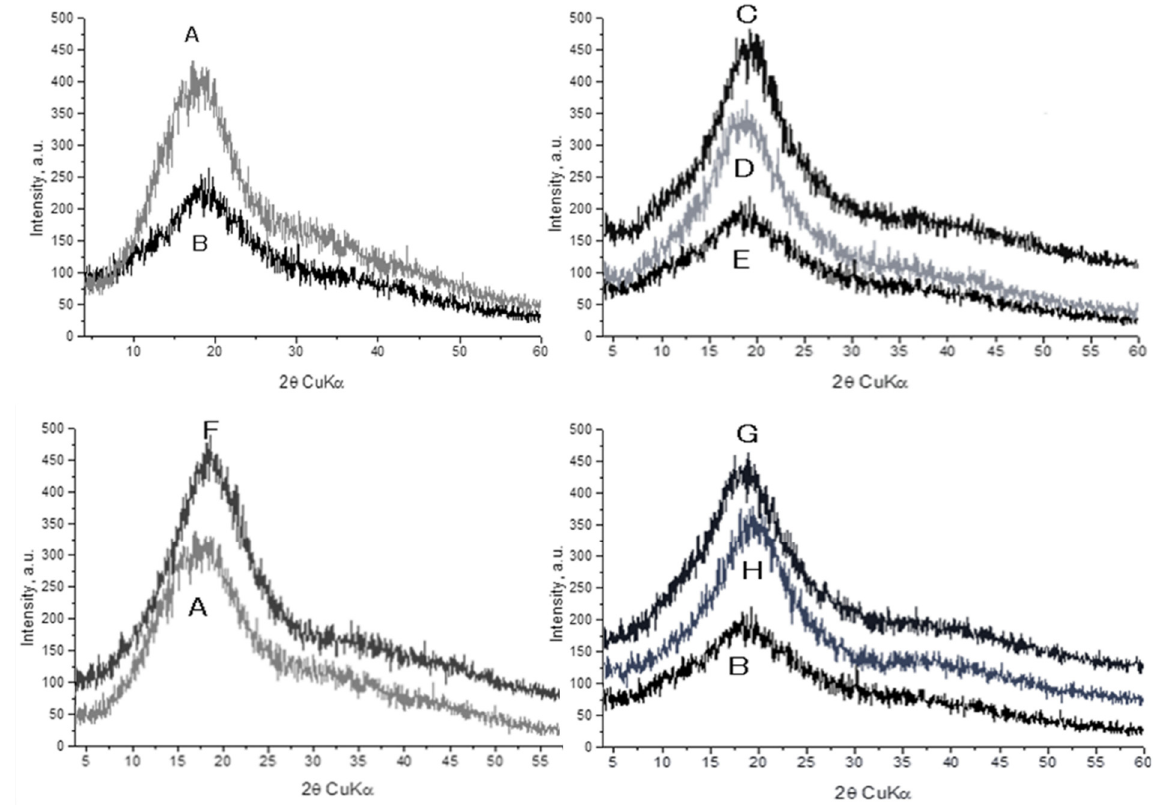
Figure 2. XRD spectra of the raw materials and the formulated samples: maltodextrin ( A ), Arabic gum ( B ), LO-2.5-AG-10 ( C ), LO-5-AG-20 ( D ), LO-5-AG-MD-10/10 ( E ), LO-5-MD-20 ( F ), PO-5-AG-20 ( G ), PO-2.5-AG-10 ( H ).